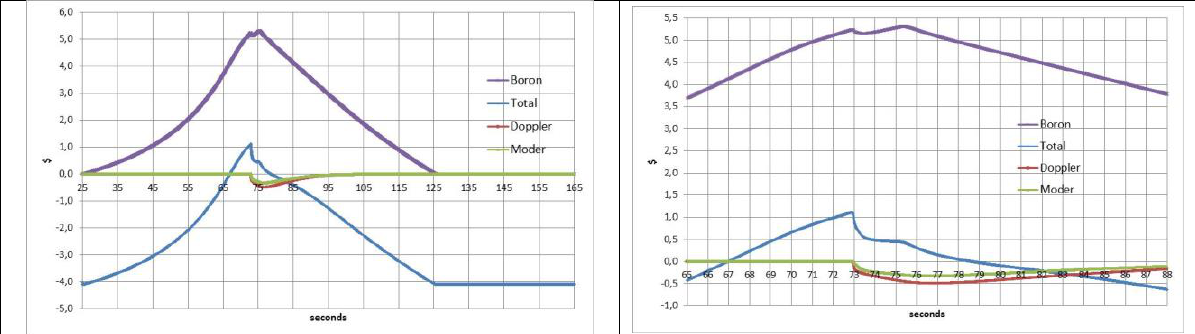
Figure 4 : Inhomogeneous Dilution – Core Reactivities (complete and